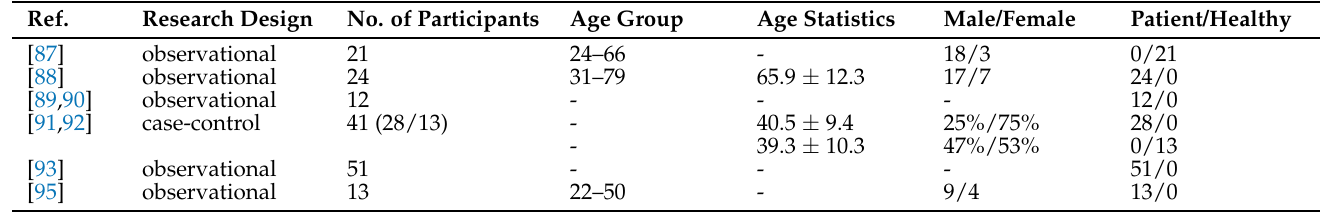
Table 9. Participant demographics for studies on neurological diseases. - = no information.